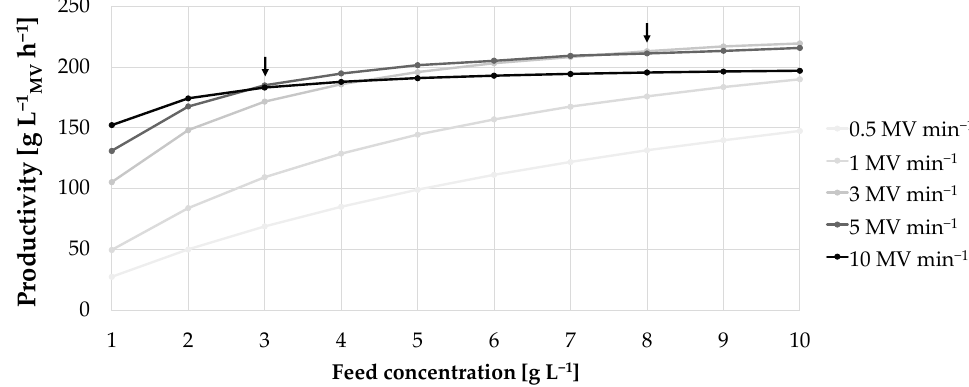
Figure 7. ( A ) Productivity as a function of product titer and flow rate during load for the convecdiff membrane prototype. Data points are based on internally investigations and calculations. ( B ) Cycle time in dependency to feed concentration.